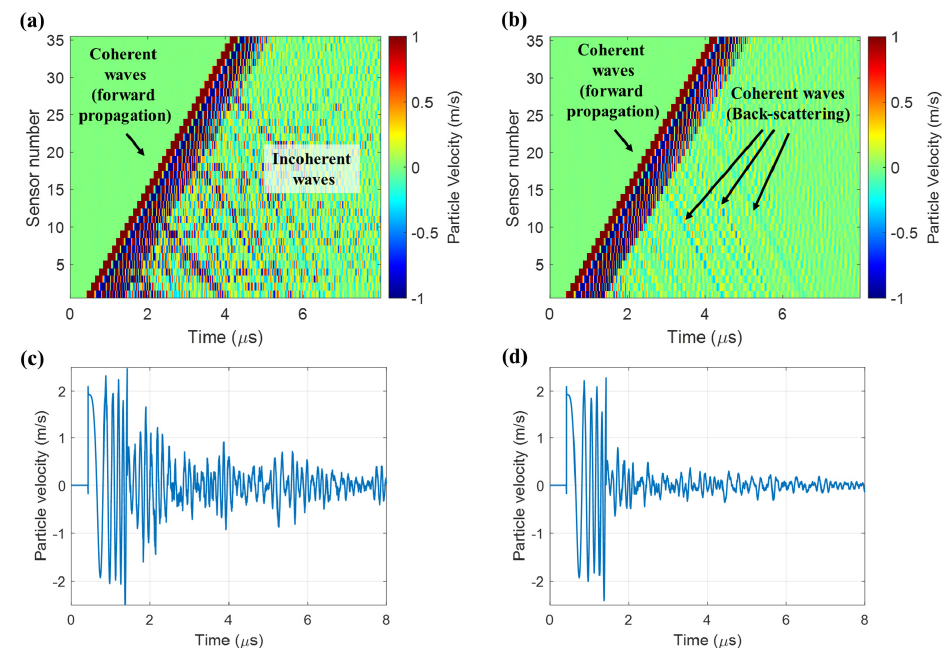
Figure 4. Acoustic wavefields for the 1% volume fraction case: ( a ) wavefield for a single realization and ( b ) ensemble-average wavefield. Acoustic wave signals at the first sensor position for the two cases are shown in ( c ) and ( d ), respectively.